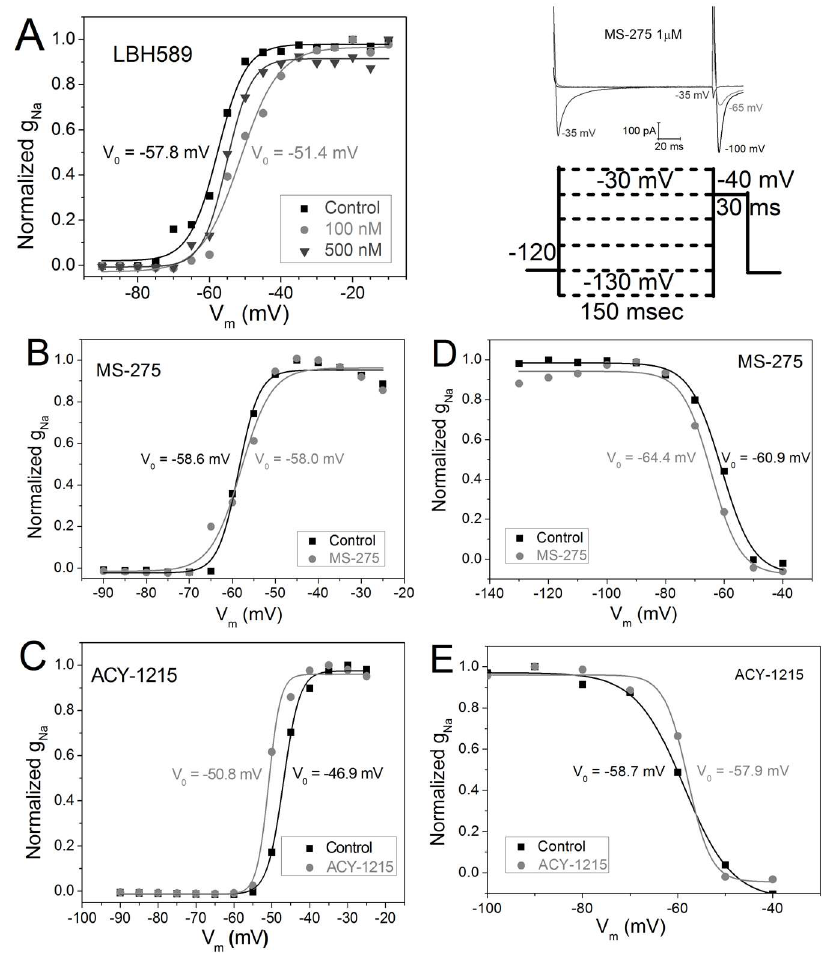
Figure 4. Effect of HDAC inhibition on V m -dependent I Na activation and inactivation. ( A ) V m -